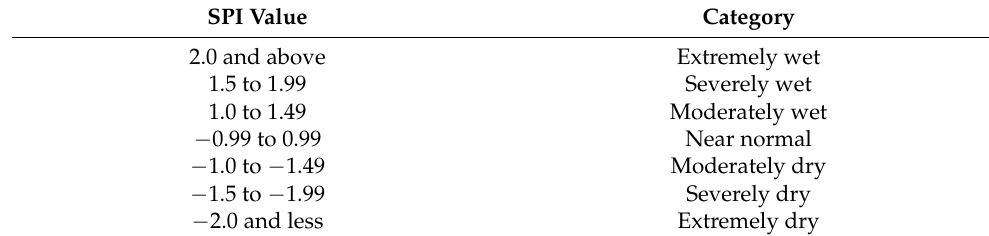
Table 2. Drought classification according to SPI